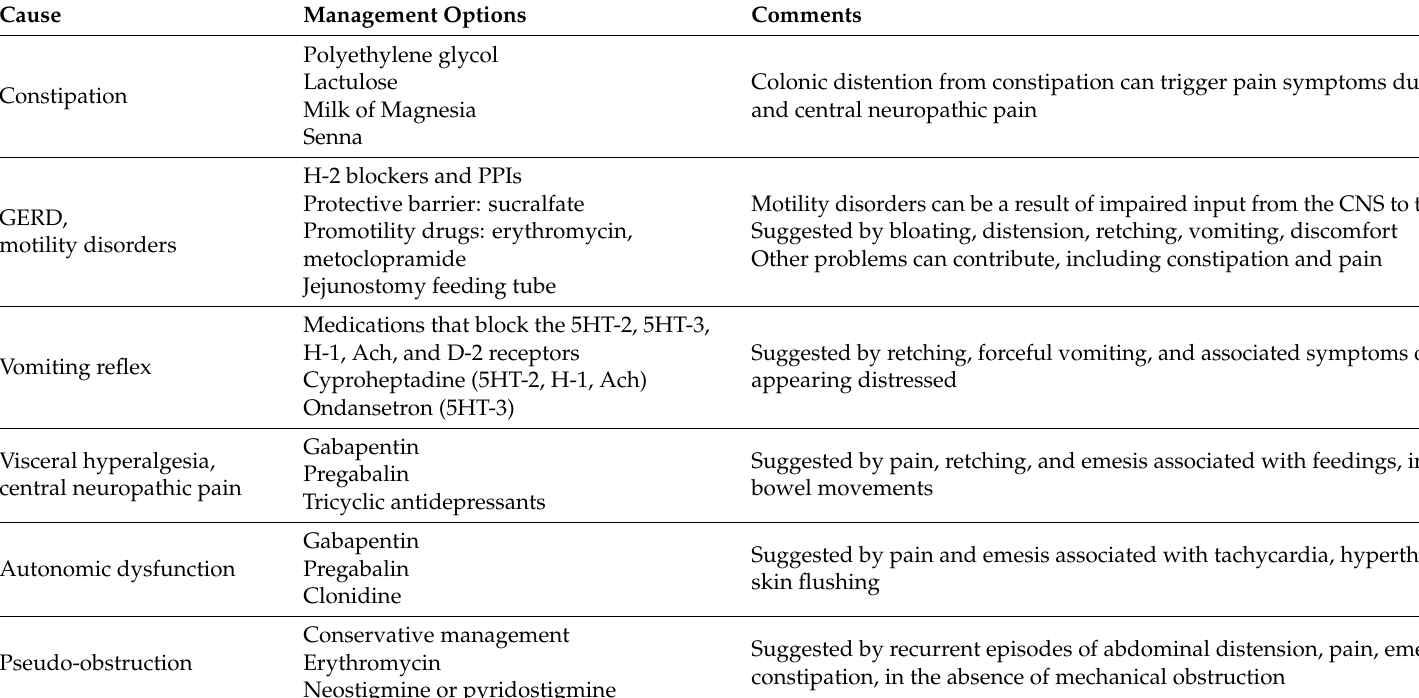
Table 1. Chronic sources of retching, emesis, and visceral